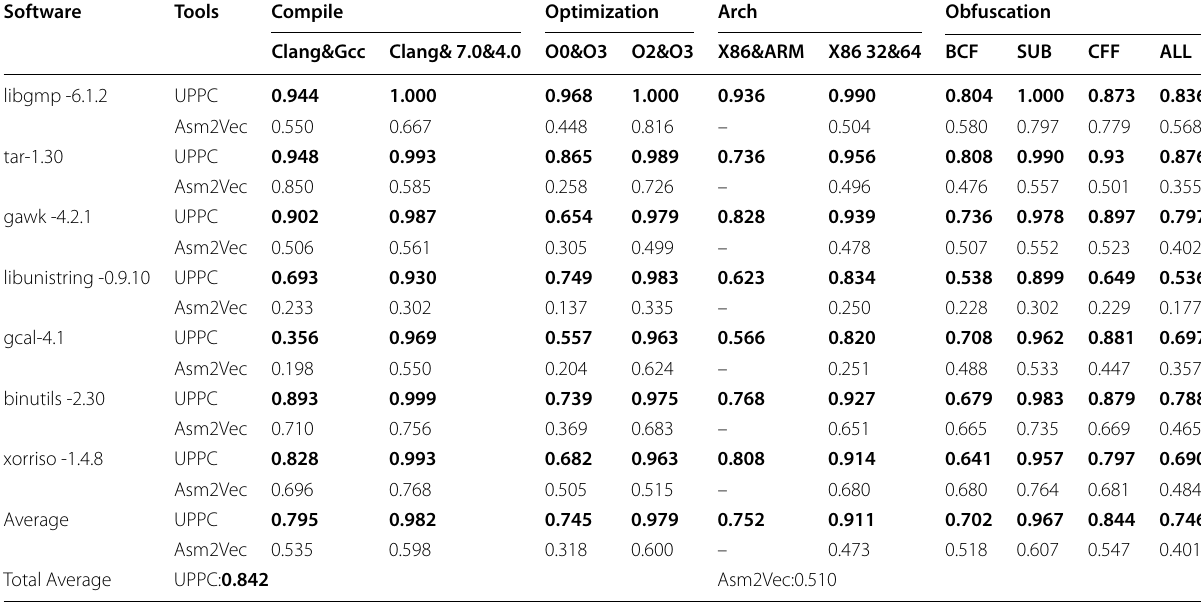
Table 4 Function search results, using the Recall @1 metric Software Tools